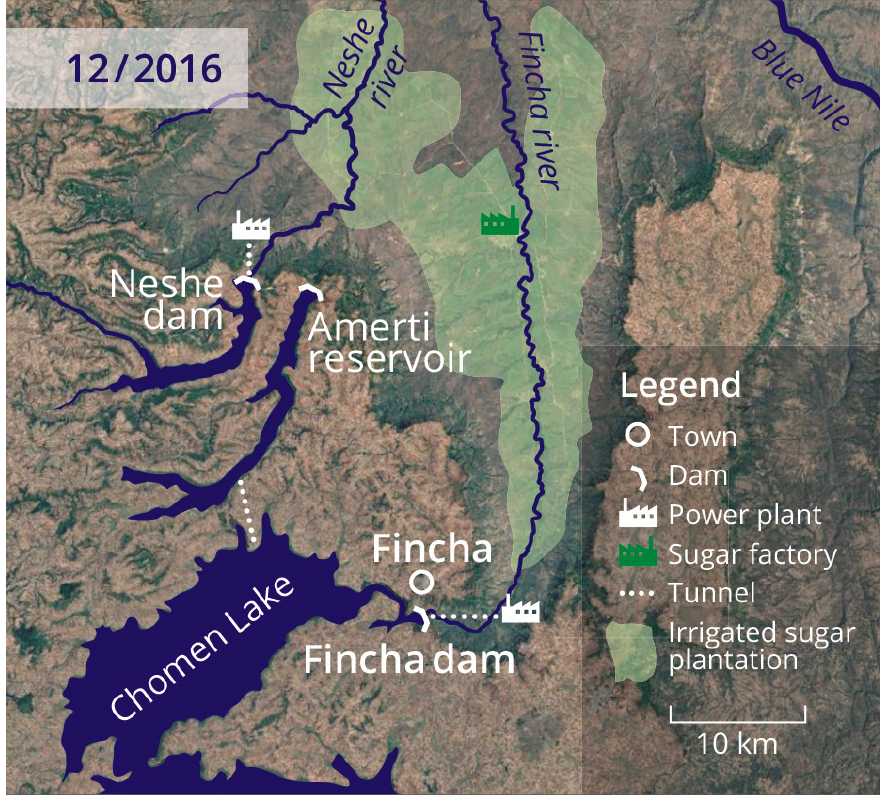
Figure 5. The study site after completion of Fincha-Amerti-Neshe scheme (2012) in December 2016.